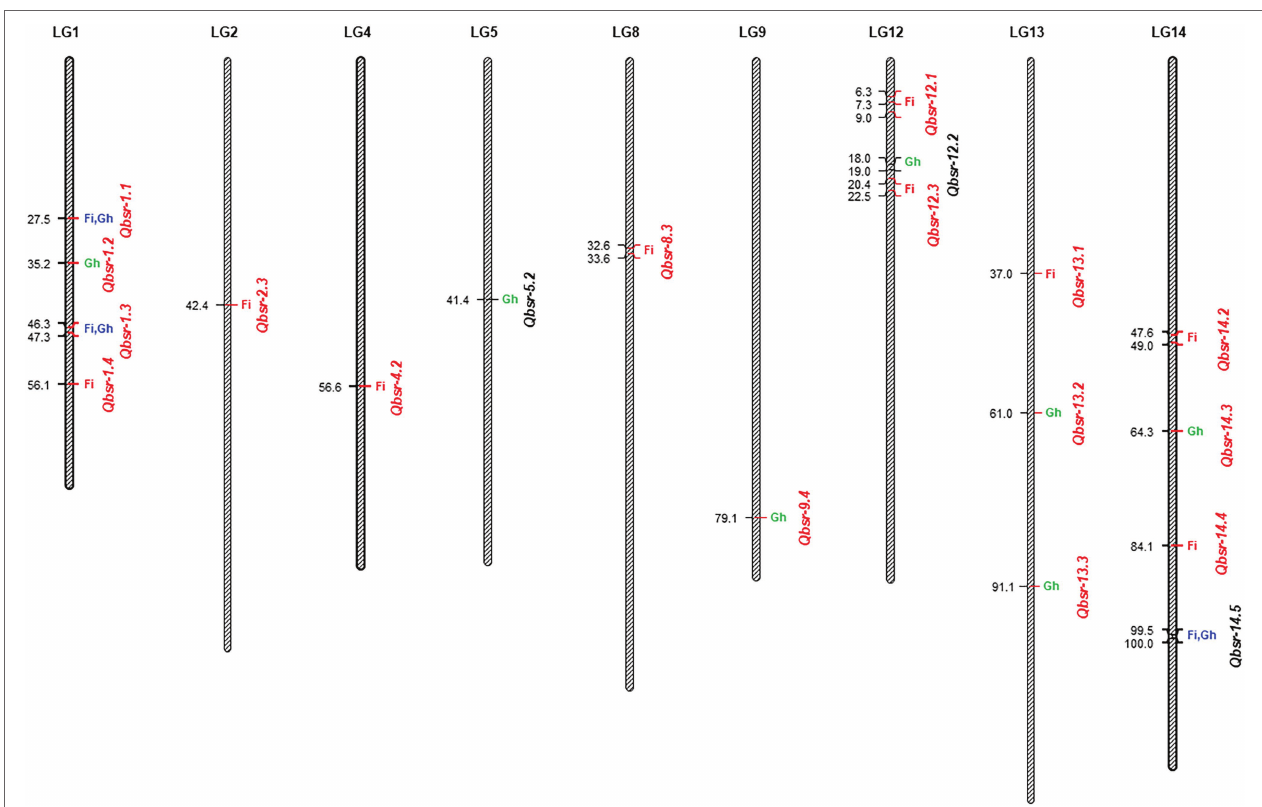
FIGURE 2 | Quantitative trait loci (QTL) associated with Sclerotinia basal stalk rot (BSR) resistance identified in the HA 89/ Helianthus praecox advanced backcross population. The QTL where BSR resistance alleles derived from the wild Helianthus praecox parent were indicated in red fonts. Fi, field environment; Gh, greenhouse